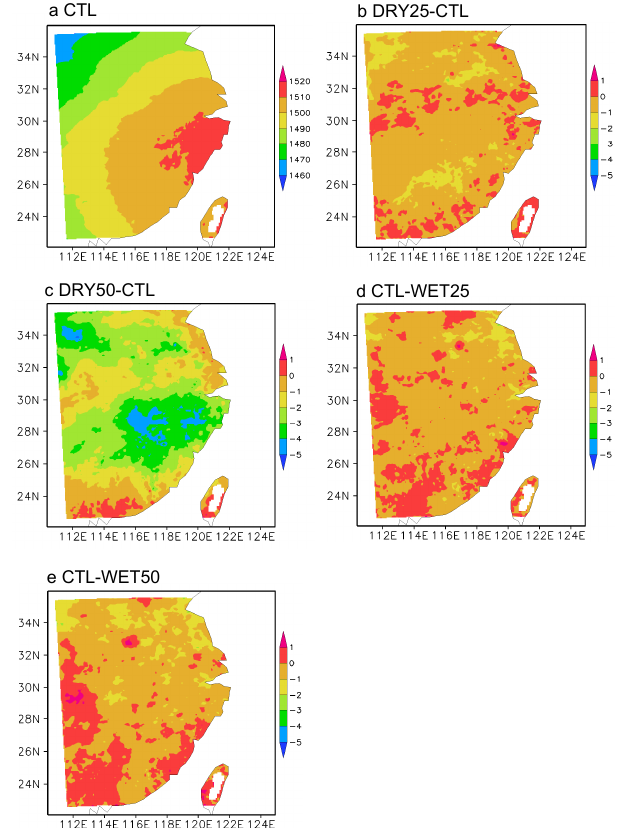
Figure 12. As Fig. 11 but for 850hPa.